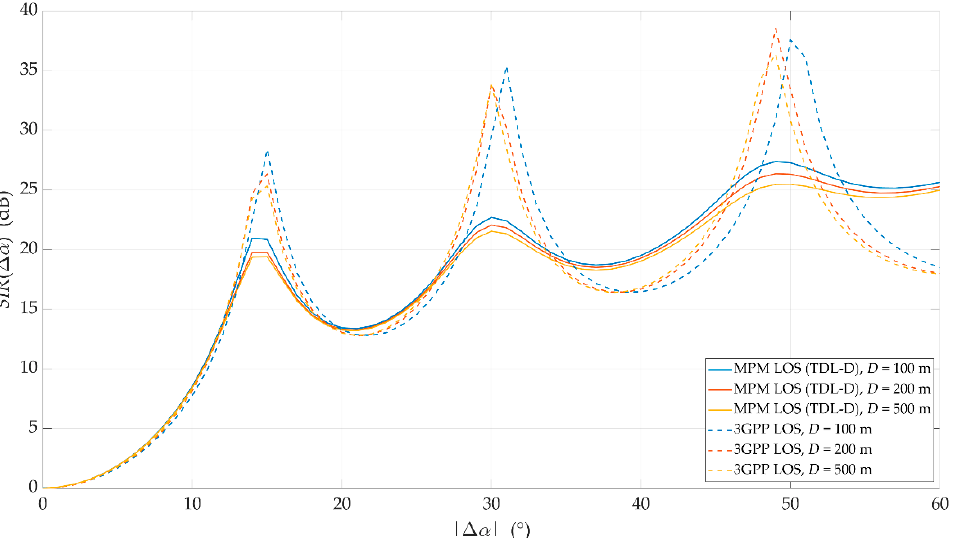
Figure 7. Signal ‐ to ‐ interference ratios (SIRs) versus angle of beam separation for line ‐ of ‐ sight (LOS) conditions and different UE–gNodeB distances obtained for the multi ‐ elliptical propagation model (MPM) and 3GPP model.